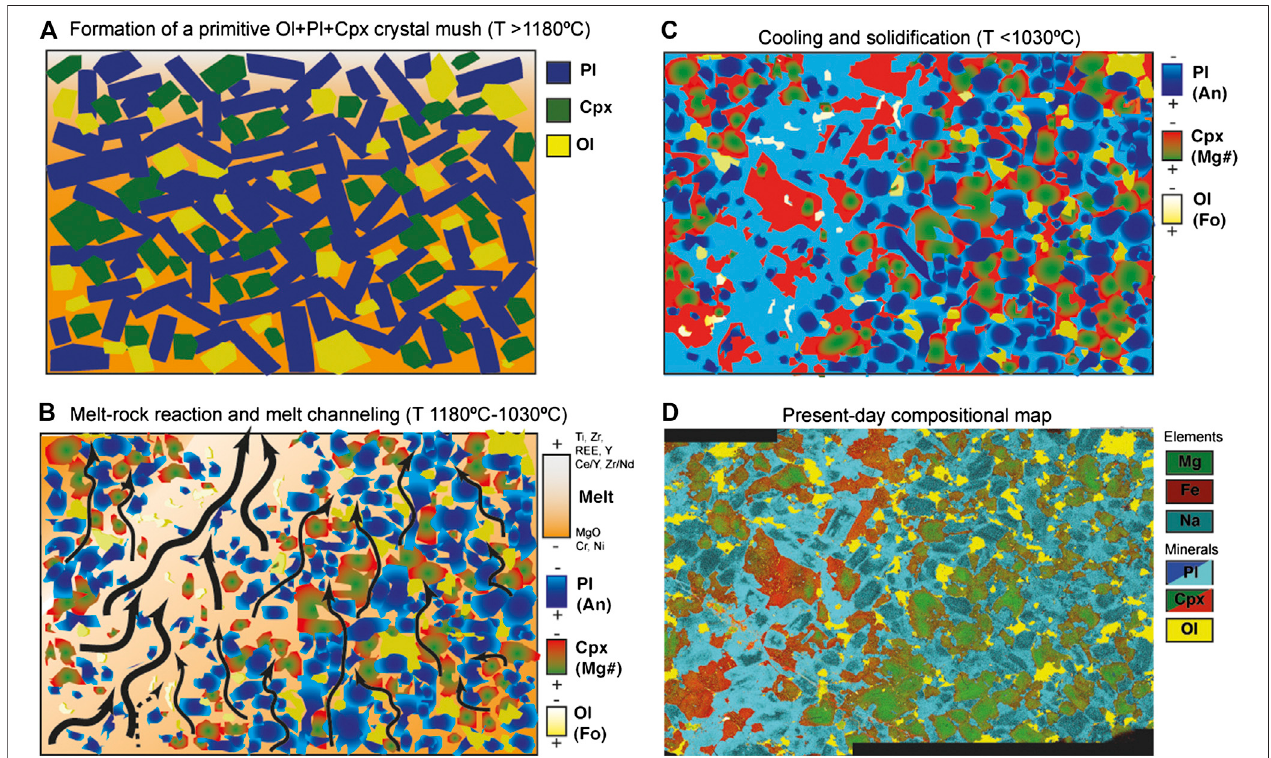
FIGURE 12 | Schematic cartoon representing the textural and chemical evolution of the sample and the formation of the replacive band in three steps (see text for details). The compositional map is also shown for comparative purposes.